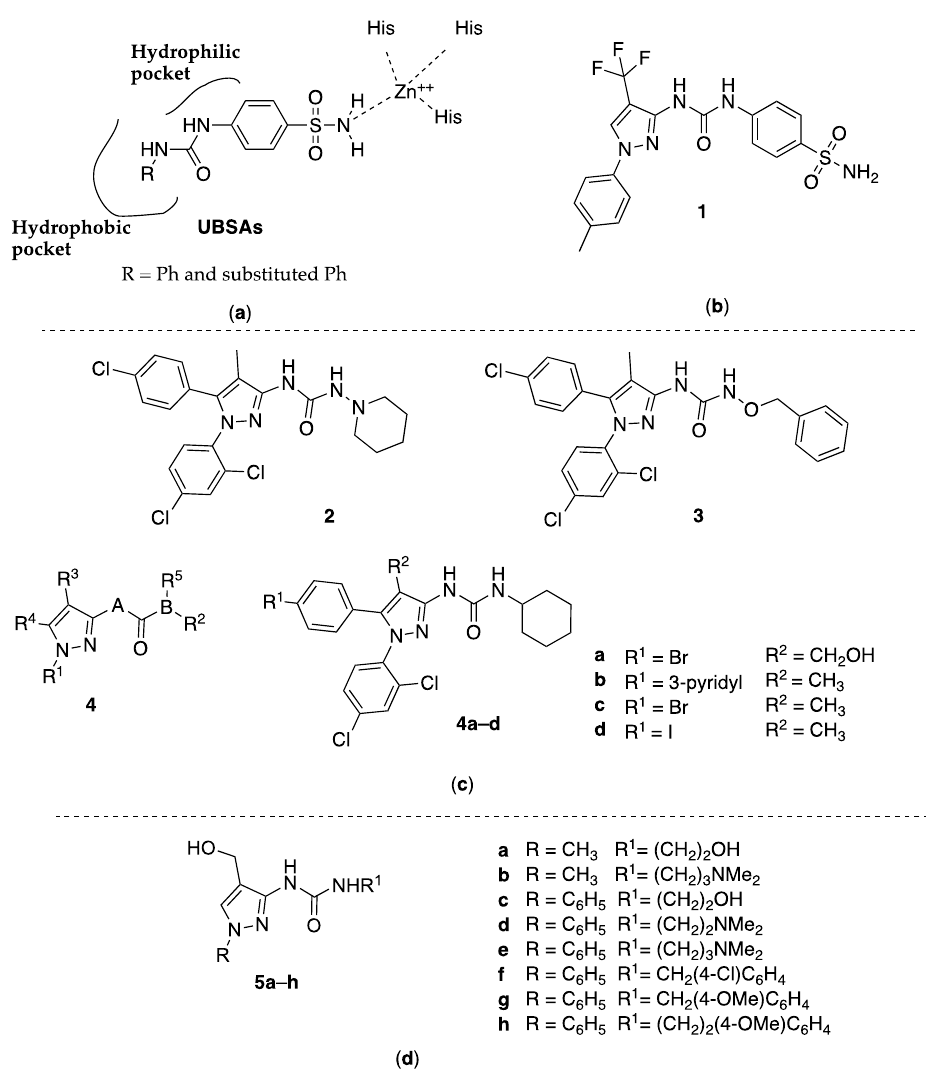
( 5a – h , Figure 1) based on the interaction of 4-